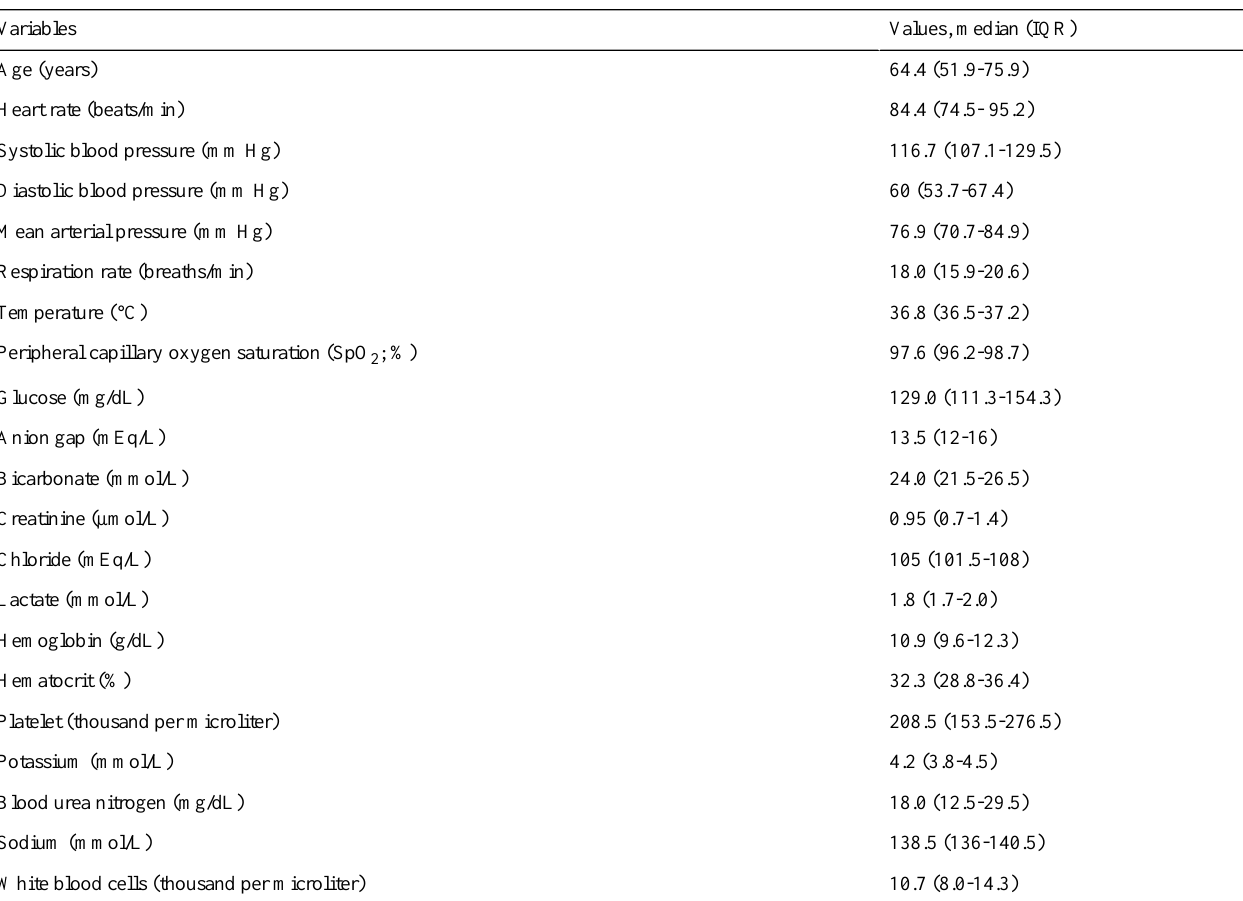
Table 2. Distribution of clinical variables in the study